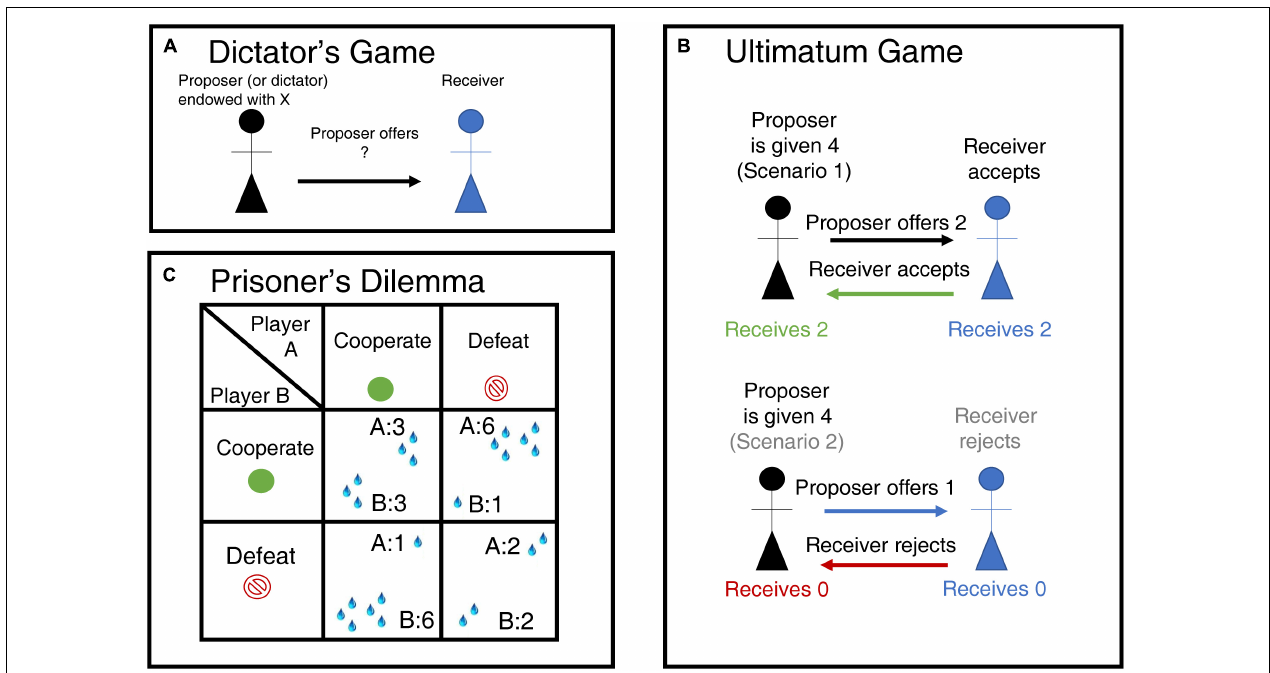
FIGURE 4 | Experimental games used to probe social decision-making. (A) Dictator Game. In the Dictator Game the person playing as dictator receives an initial financial endowment and decides to give an amount of the endowment to a receiver. The neoclassical assumption of rational behavior predicts that dictators will not give away anything of their payoff; however, dictators usually give away between 5 and 25% of their initial endowment (Forsythe et al., 1994). It is assumed that the proportion of money given to the receiver is a measure of the disutility for the dictator of having more than the other (Gibbons, 1992; Camerer et al., 2004). (B) Ultimatum Game. In this game, the proposer receives an endowment and proposes a split to the responder, just as in the Dictator Game. The responder then either rejects the split, thereby forgoing all monies, or accepts it. Neoclassical economic models predict that the responder will accept any split that results in him having more than nothing. However, responders tend to only accept splits where they obtain more than 30% of the initial endowment (Güth et al., 1982). The responder’s minimum acceptable offer is the percentage of the initial endowment that he is willing to accept 50% of the time (Camerer et al., 2004). This last parameter is directly proportional to the degree of disadvantageous inequality aversion. Some have suggested, instead, that rejecting an offer is a form of altruistic punishment that can foment future cooperation (e.g., Sanfey et al., 2003). (C) Prisoner’s Dilemma. In this game, two players choose between cooperation or defection. Mutual cooperation results in a medium-size reward for both players, while mutual defection results in a small reward. But if one of them defects then they receive the highest reward, the tempting reward, while the other receives the lowest, or sucker’s, payoff. The game tests the ability of both players to cooperate and trust